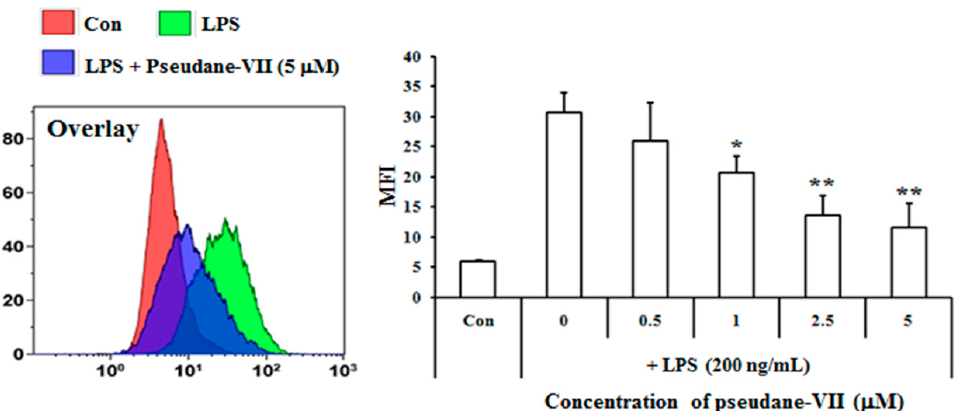
Figure 2. Pseudane-VII inhibits LPS-induced NO and ROS production in BV-2 microglial cells. Cells (2 × 10 4 cells/well) were cultured in 96-well culture plates at 37 °C in presence of 5% CO 2 . Seeded cells were pretreated with various concentrations (0.5, 1, 2.5, and 5 μ M) of pseudane-VII for 2 h and were added with LPS (200 ng/mL) for 22 h. ( A ) NO production was determined by Griess assay. Absorbance was measured at 540 nm using microplate reader. ( B ) ROS production was determined by FACS analysis using DCFDA. The result is representative of repeated three independent experiments. Experimental results were indicated as mean (±SE) (* p < 0.05, ** p < 0.001 vs. LPS- stimulated group).